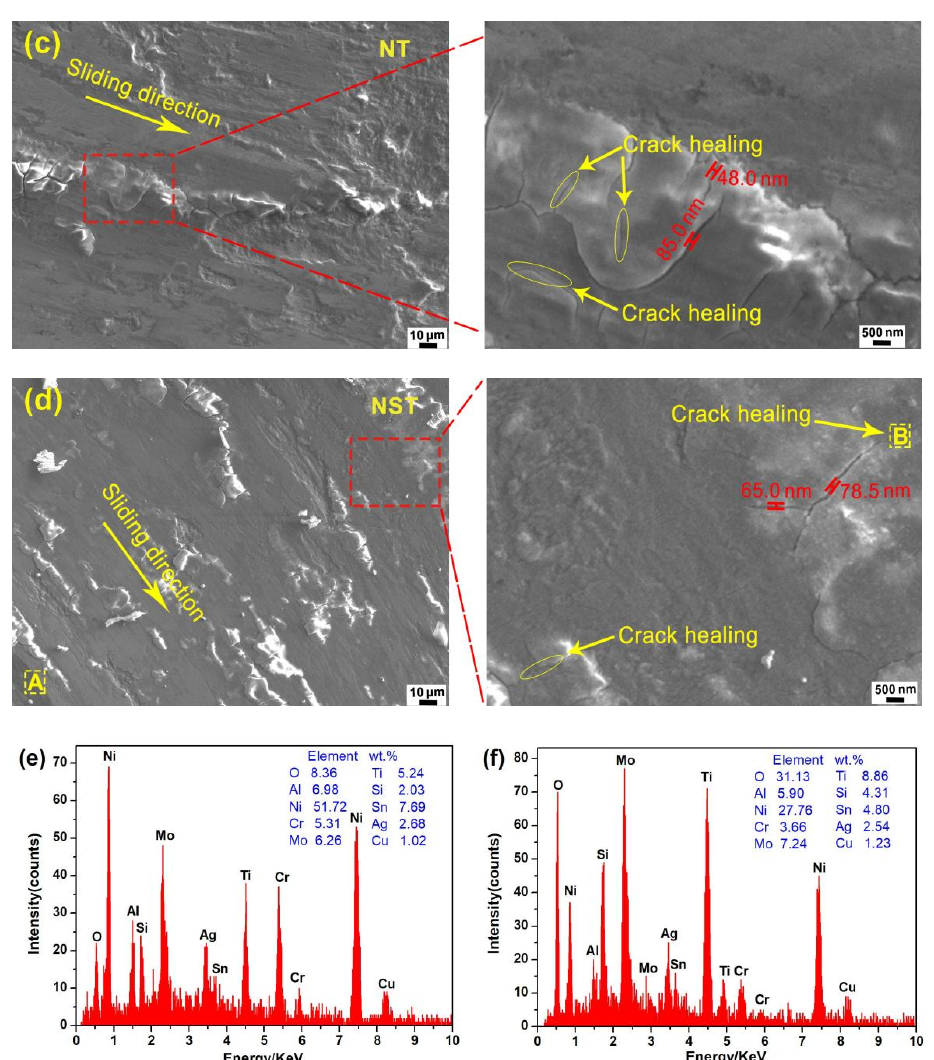
Figure 7. Worn surface morphologies of NBA, NS, NT and NST at 600 °C ( a – d ); EDS results of the areas marked by boxes A and B in ( d ): box A at the edge zone of the worn surface ( e ), box B at the crack healing area ( f ).